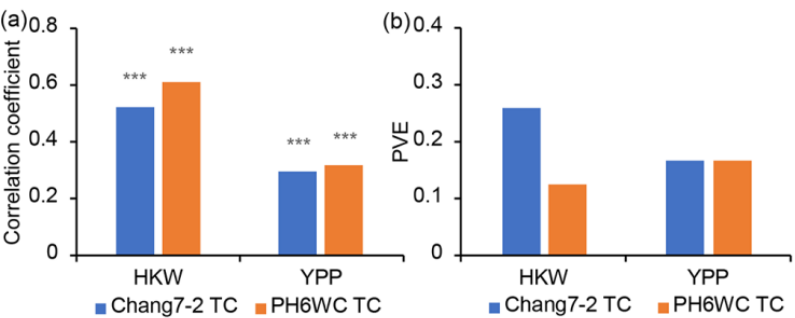
Figure 5. The relationship between LPS and TC populations. ( a ) Correlation coefficients between LPS and each of the two TC populations; *** indicates significance at 0.001 level. ( b ) Phenotypic variance of TC populations explained by the significant SNPs detected in the LPS